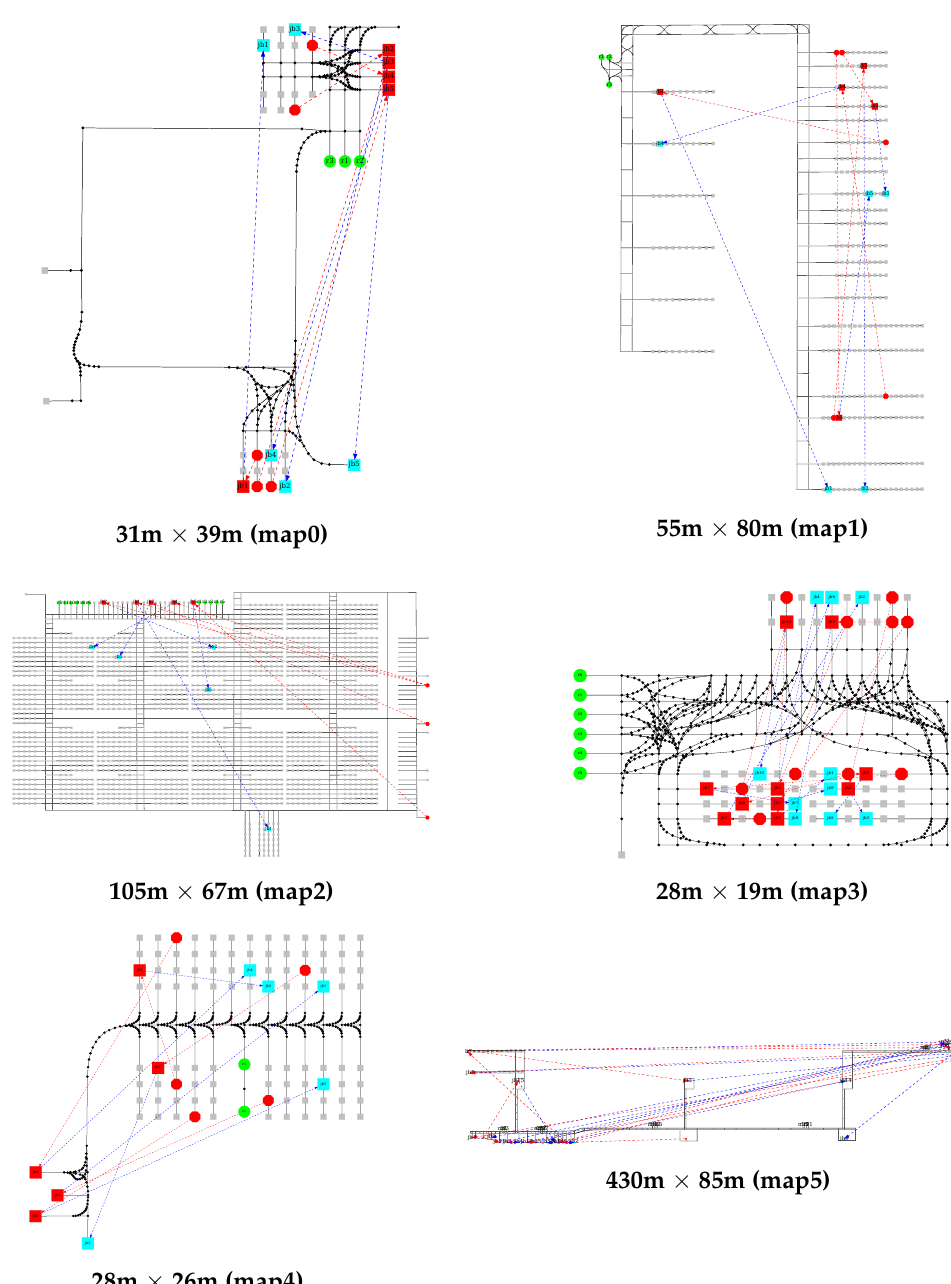
Figure 6. Example instances for the real-world warehouse graph. Circular green vertices indicate robot home locations. Square red vertices indicate full pallet pickup locations with a dotted blue arrow pointing to the corresponding storage location. Octagonal red vertices indicate empty pallet pickup locations with a dotted red arrow pointing to the delivery location for the corresponding empty